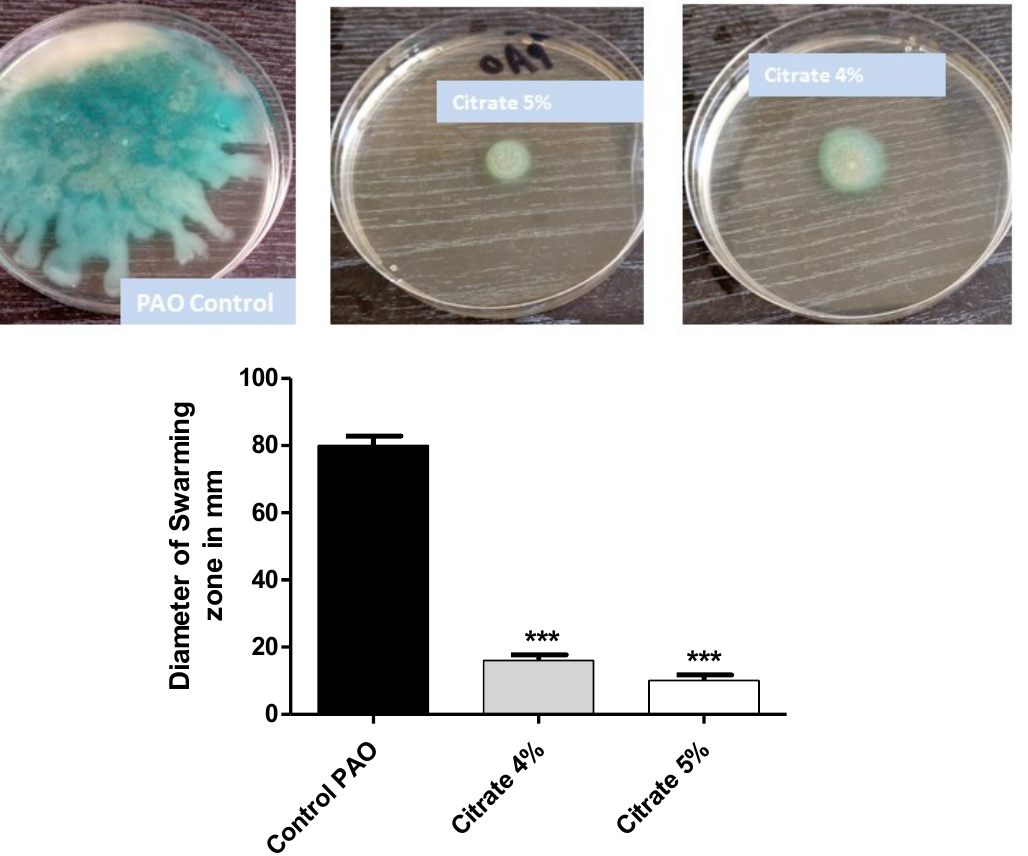
Figure 3. Sodium citrate curtails P. aeruginosa motility. The diameters of P. aeruginosa swarming were measured in agar plates provided or not with 4% or 5% sodium citrate. Sodium citrate significantly diminished bacterial motility (*** = p < 0.0001).